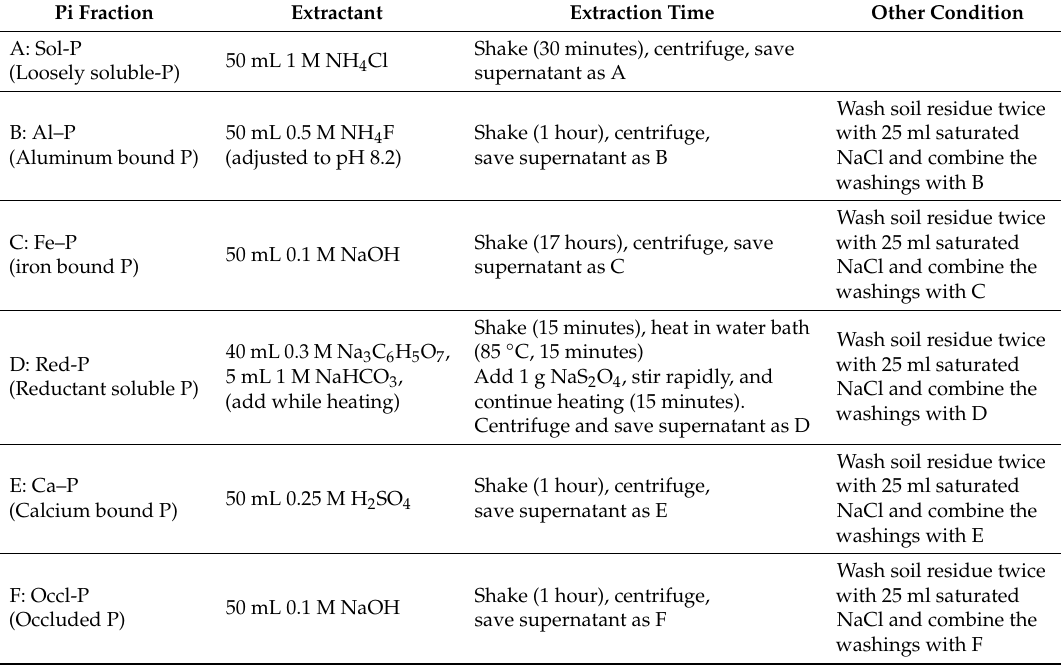
Table 1. Sequential extraction procedure of inorganic phosphorus.